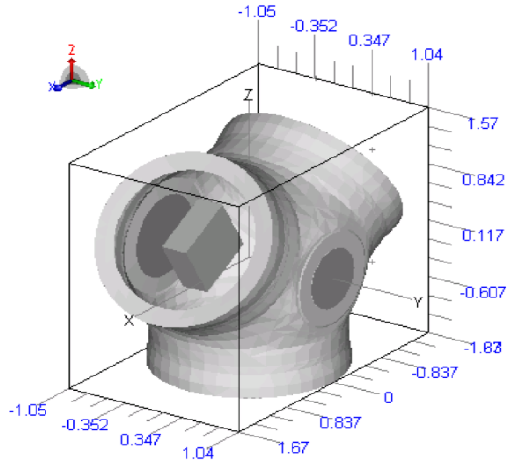
Figure 1. Wind turbine’s hub electromagnetic model [23].